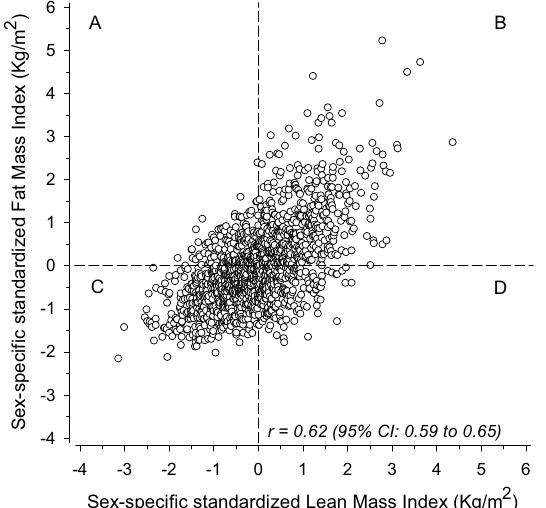
Figure 1. Categorizing participants into groups based on sex-specific standardized Fat Mass Index (FMI) and Lean Mass Index (LMI). The dashed lines represent mean values. Both axes represent z-scores. The letters A, B, C, D represent the 4 body composition groups. A: above mean fat mass index (FMI) and below mean lean mass index (LMI), B: above mean FMI and above mean LMI, C: below mean FMI and below mean LMI, D: below mean FMI and above mean